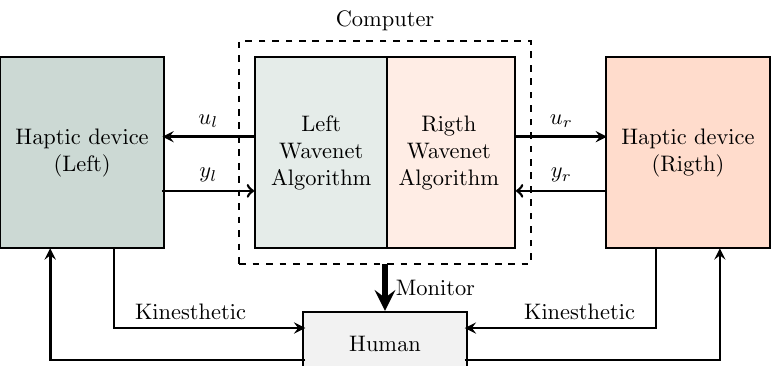
Figure 2. Block diagram of the bimanual cooperative system, showing the multimodal stimuli to the human, consequently the human decision making process solves cooperativeness to issue simultaneously motor commands to each device.